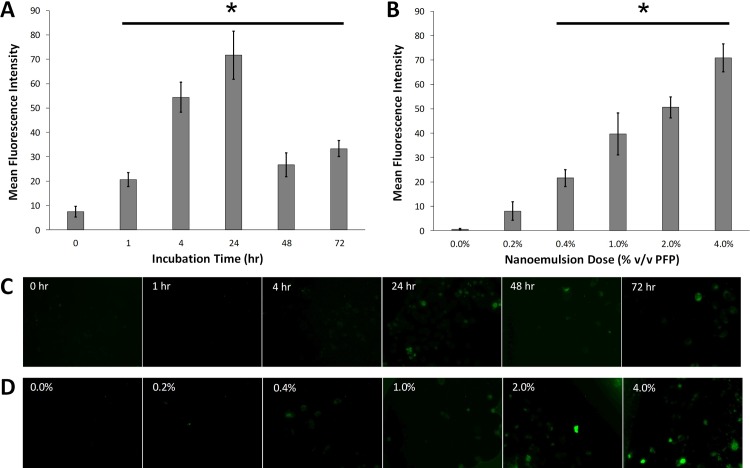
The mean fluorescence intensity of MDA-MB-231 cancer cells incubated with fluorescent AS1411-conjugated nanodroplets as a function of (A) time and (B) dose (%v/v PFP) after 72 hr (n = 10). Representative fluorescence microscopy images at each (C) time point and (D) dose indicate uptake of nanodroplets compared to the initial control sample.